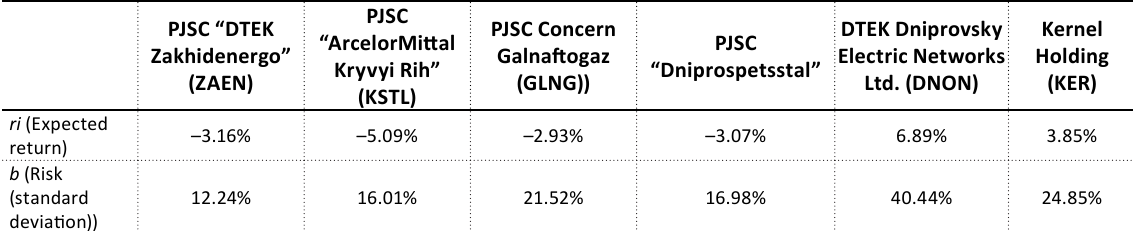
Table 3. Mathematical expectation of return and risk for shares of enterprises with implemented CSR strategies